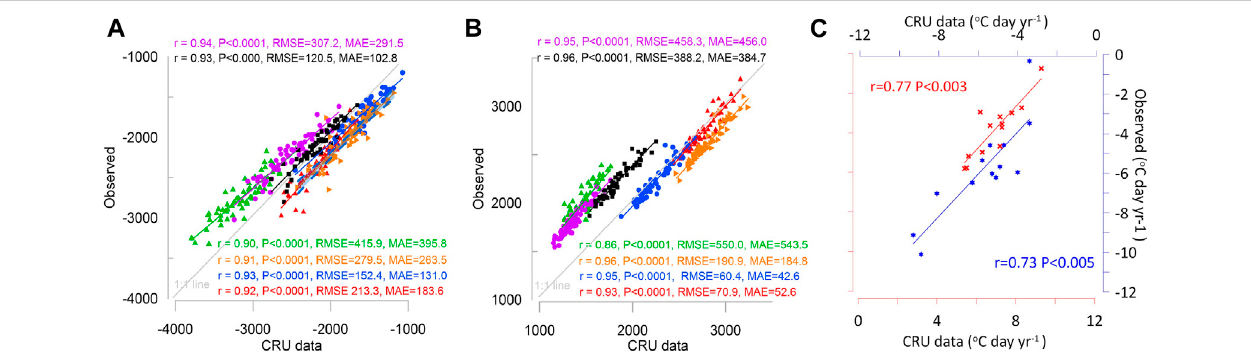
FIGURE 5 | Comparison between CRU data and observed data at the six sites (A) for freezing index and (B) thawing index. Note: The pink, black, green, orange, blue, and red colours in (A,B) represent the Alt, BKh, UL, MG, AR, and B-U regions, respectively. For comparison, the closest meteorologicalstation tothe center of the CRUgrid cellhasbeenselected. Thecomparisonperiod isthesameasshown theobservationperiod in Table1 . (C) Linearregressionbetweentrendsoffreezingindex (blue colour) and thawing index (red colour) from observation and CRU data. For the comparison, trends were calculated between 1960 and 2019 at 13 stations which have full observations from 1960 to 2020 as shown in Table 1 , with CRU grid cells selected as in (A,B) .